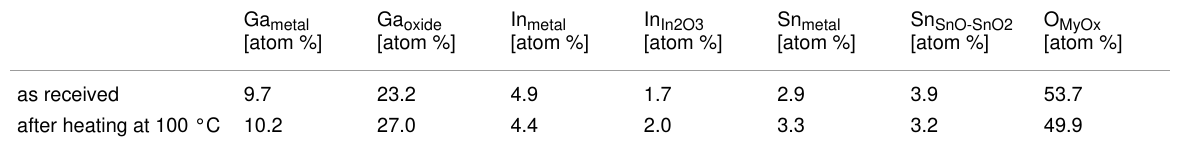
Table 3: Surface chemical composition of Ga–In–Sn eutectic melt (a) before and (b) after heating for 3 h at 100 °C.